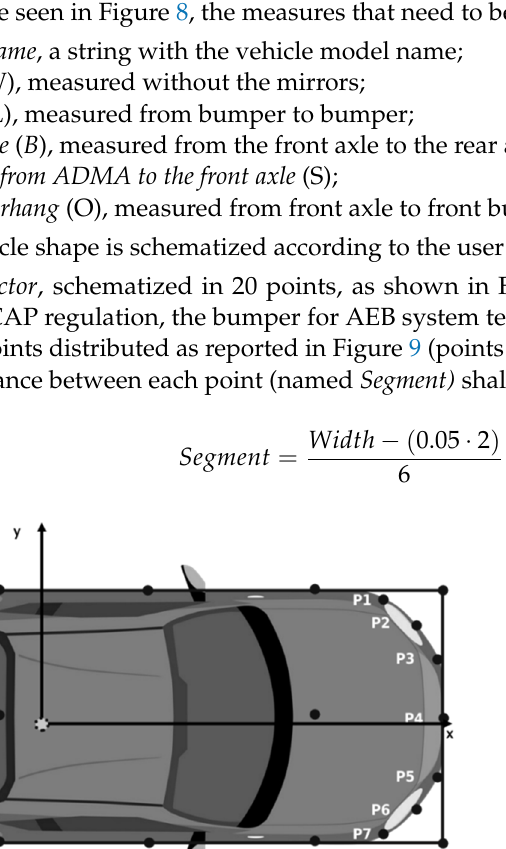
Figure 8. New vehicle window.